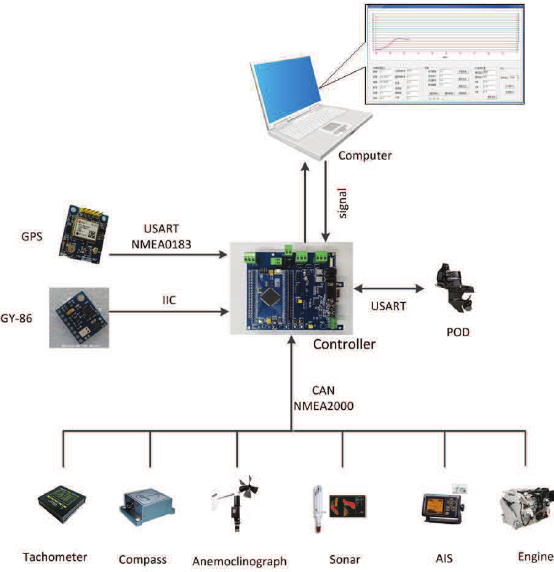
Figure 3. Multi-sensor